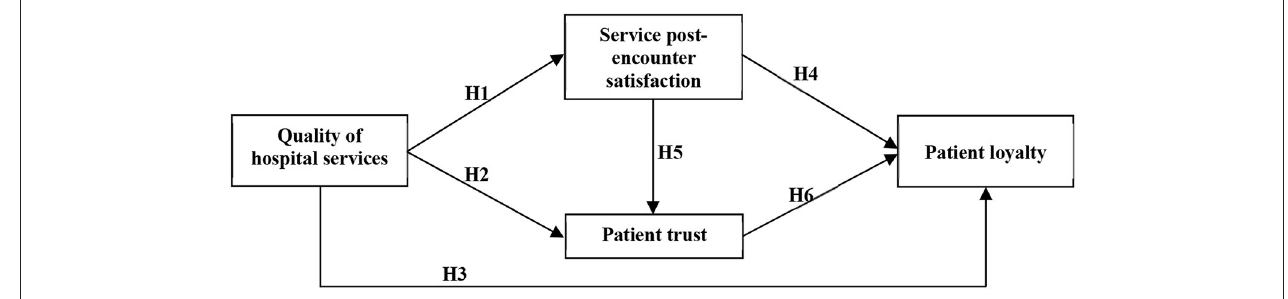
FIGURE 1 | Research